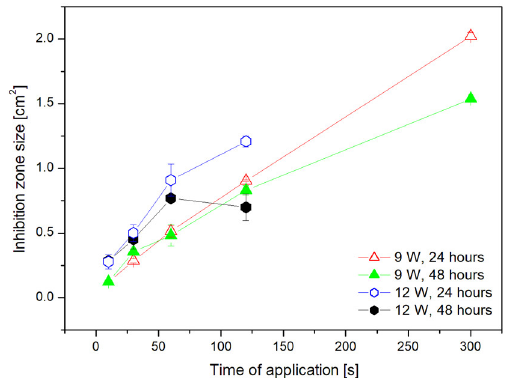
Figure 3. The dependence of the inhibition zone size on the plasma exposure time for the original undiluted culture.